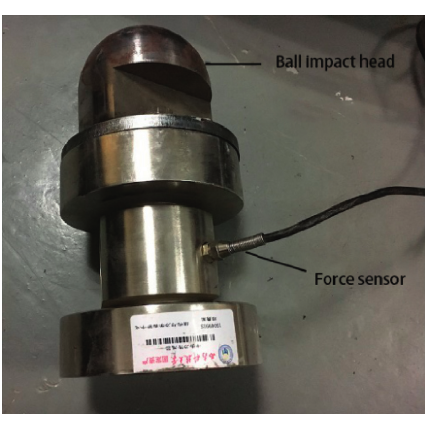
Figure 11: Impact sensor and spherical impact head.